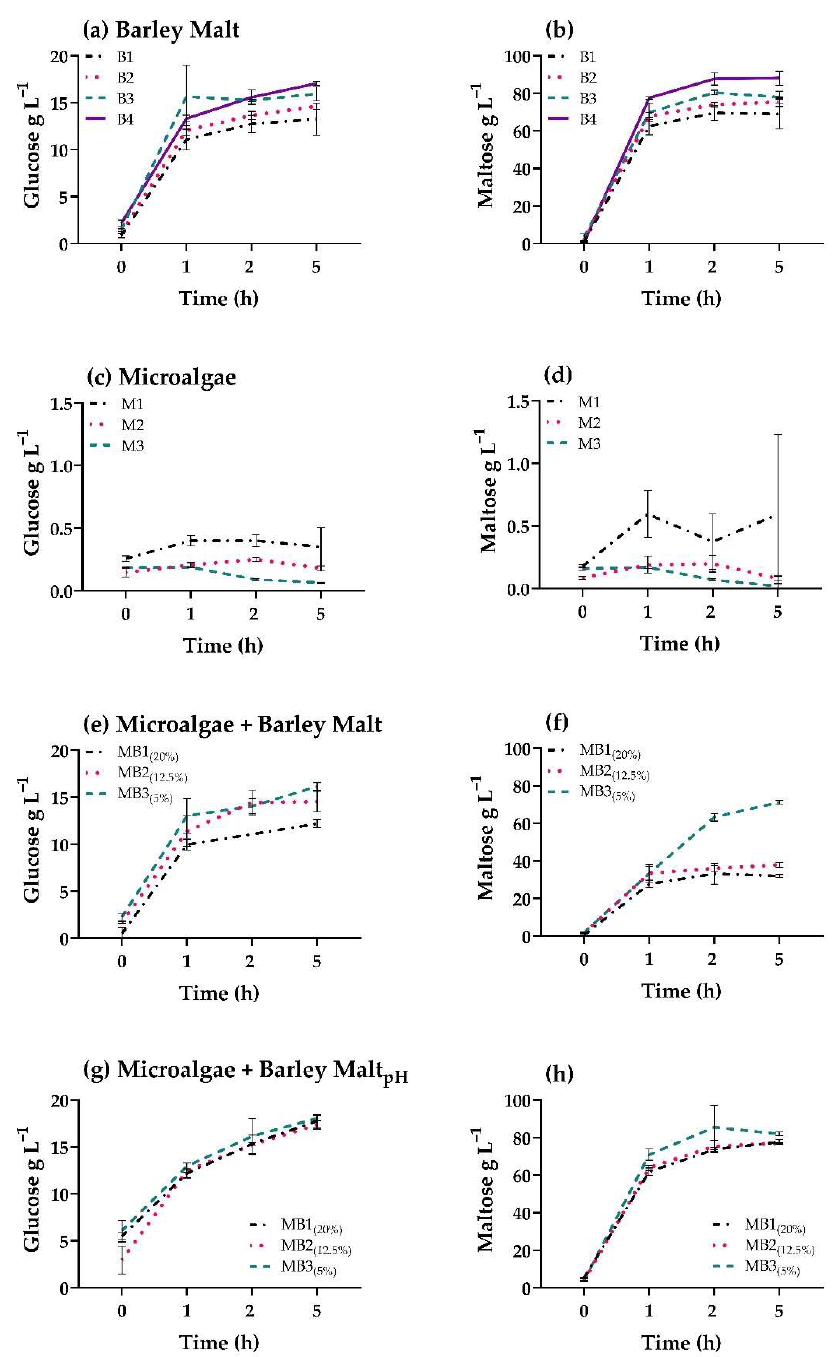
Figure 4. Glucose and maltose accumulation in the wort during mashing experiments with barley malt and starch-rich T. chui biomass. ( a , b ) Mashing with barley malt; B1-4 correspond, respectively, to 2.88, 3.15, 3.42 and 3.6 g of biomass in 15 mL. ( c , d ) Mashing with starch-rich T. chui biomass; M1-3 correspond to, respectively, 0.72, 0.45 and 0.18 g of biomass in 15 mL. ( e , f ) Mashing with starch-rich T. chui biomass and barley malt mixtures without pH adjustment; 20% (MB1), 12.5% (MB2) and 5% (MB3) microalgal biomass was used over 3.6 g of total solids in 15 mL. ( g , h ) Mashing with starch-rich T. chui biomass and barley malt mixtures with pH adjustment; 20% (MB1), 12.5% (MB2) and 5% (MB3) microalgal biomass was used over 3.6 g of total solids in 15 mL. Samples were incubated over five hours at 67 ◦ C. Detailed information regarding samples is described in Figure 1. All data represent mean ± SD of triplicate